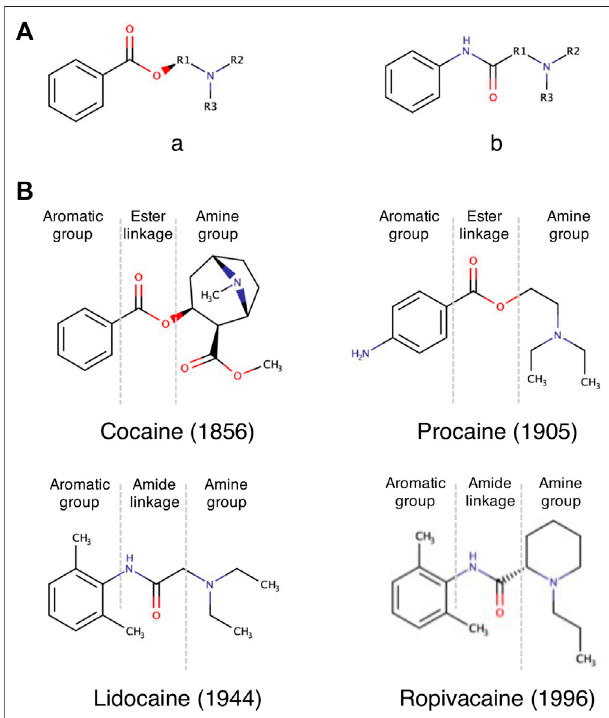
FIGURE1| OverviewofthechemicalstructureofLAs. (A) LAsconsistof two main chemical classes: The lipophilic aromatic ring can be linked to the tertiary amine by an intermediate ester (a) or amide linkage (b). (B) Example chemical structures of LAs. The name of the selected LA and their discovery date are given below each